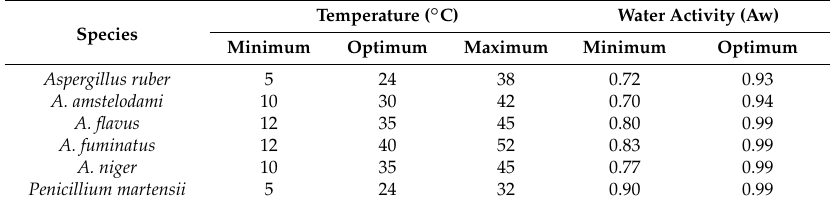
Table 2. Temperature and water activity requirements for fungal growth [54].